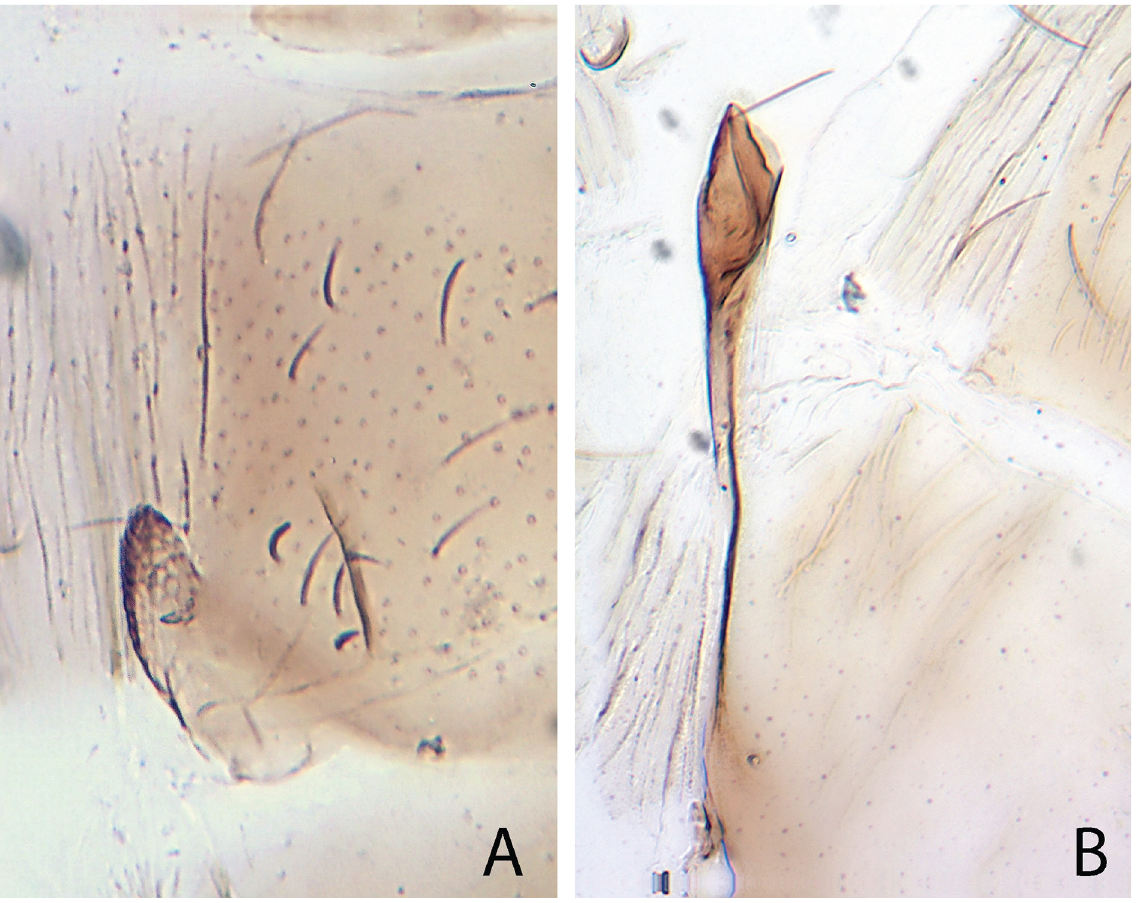
Fig. 3. Abdominal sternum V, ventral, 100 × magnification. A . Machairocentron amahuaca sp. nov. (MUSM). B . Xiphocentron harakbut sp. nov.